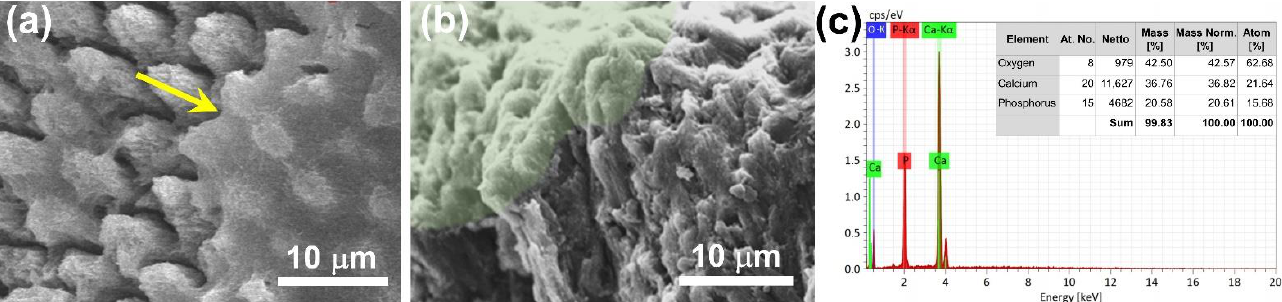
Figure 5. SEM image of tooth enamel after repair with calcium phosphate nanoclusters (CaP NCs). ( a ) The yellow arrow indicates the enamel rods covered with CaP. ( b ) Cross-sectional SEM image of the tooth enamel after repair with CaP NCs. ( c ) EDX analysis of the elemental composition of tooth enamel after repair with CaP NCs.